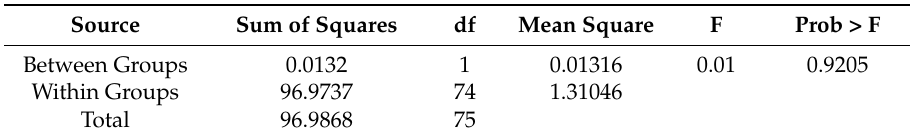
Table 5. Analysis of variance results.